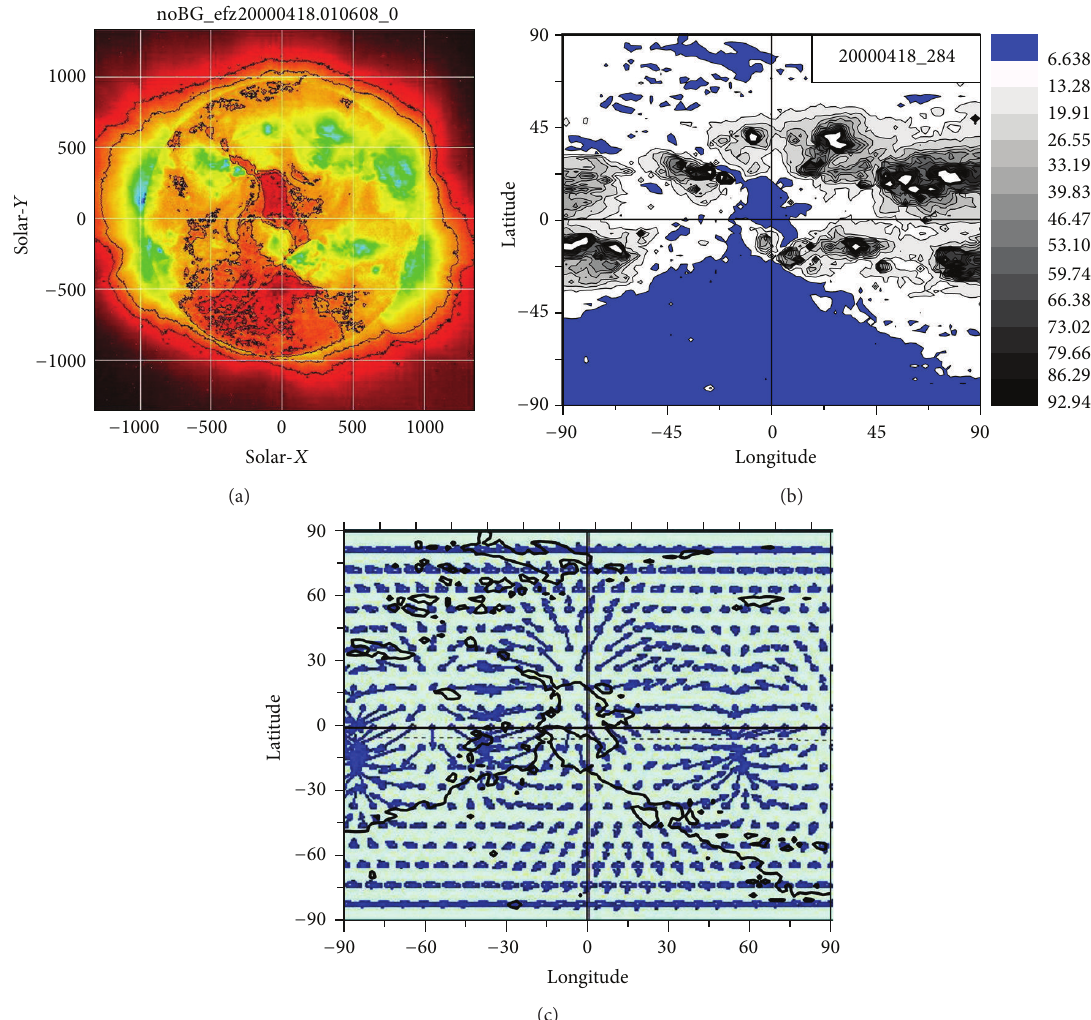
Figure 8: CH observed at the center of the disk on 18 April 2000. Panel (c) shows the structure of the tangential magnetic